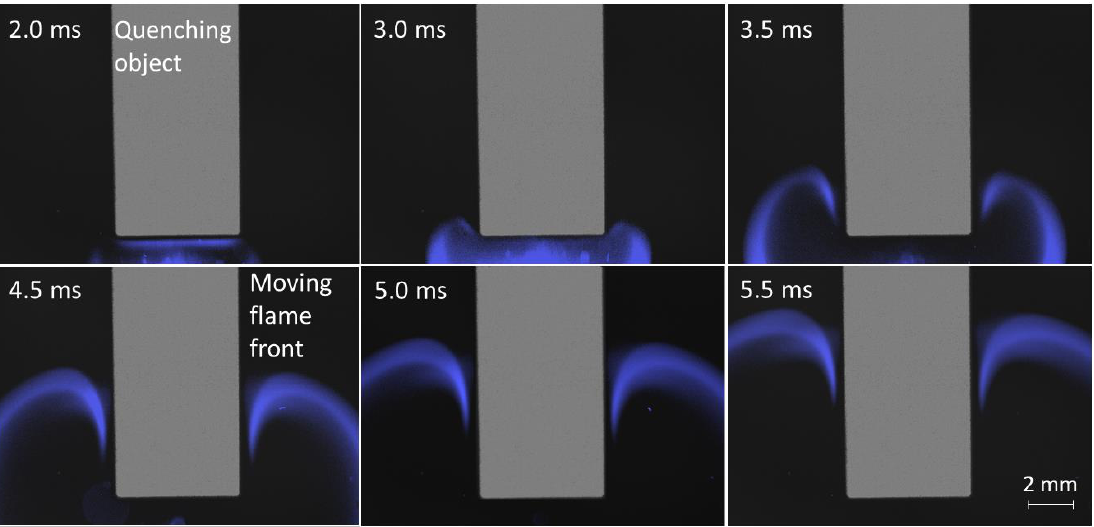
Figure 3. Transition from head-on quenching to sidewall quenching with an intensity offset of 60% maximum intensity.